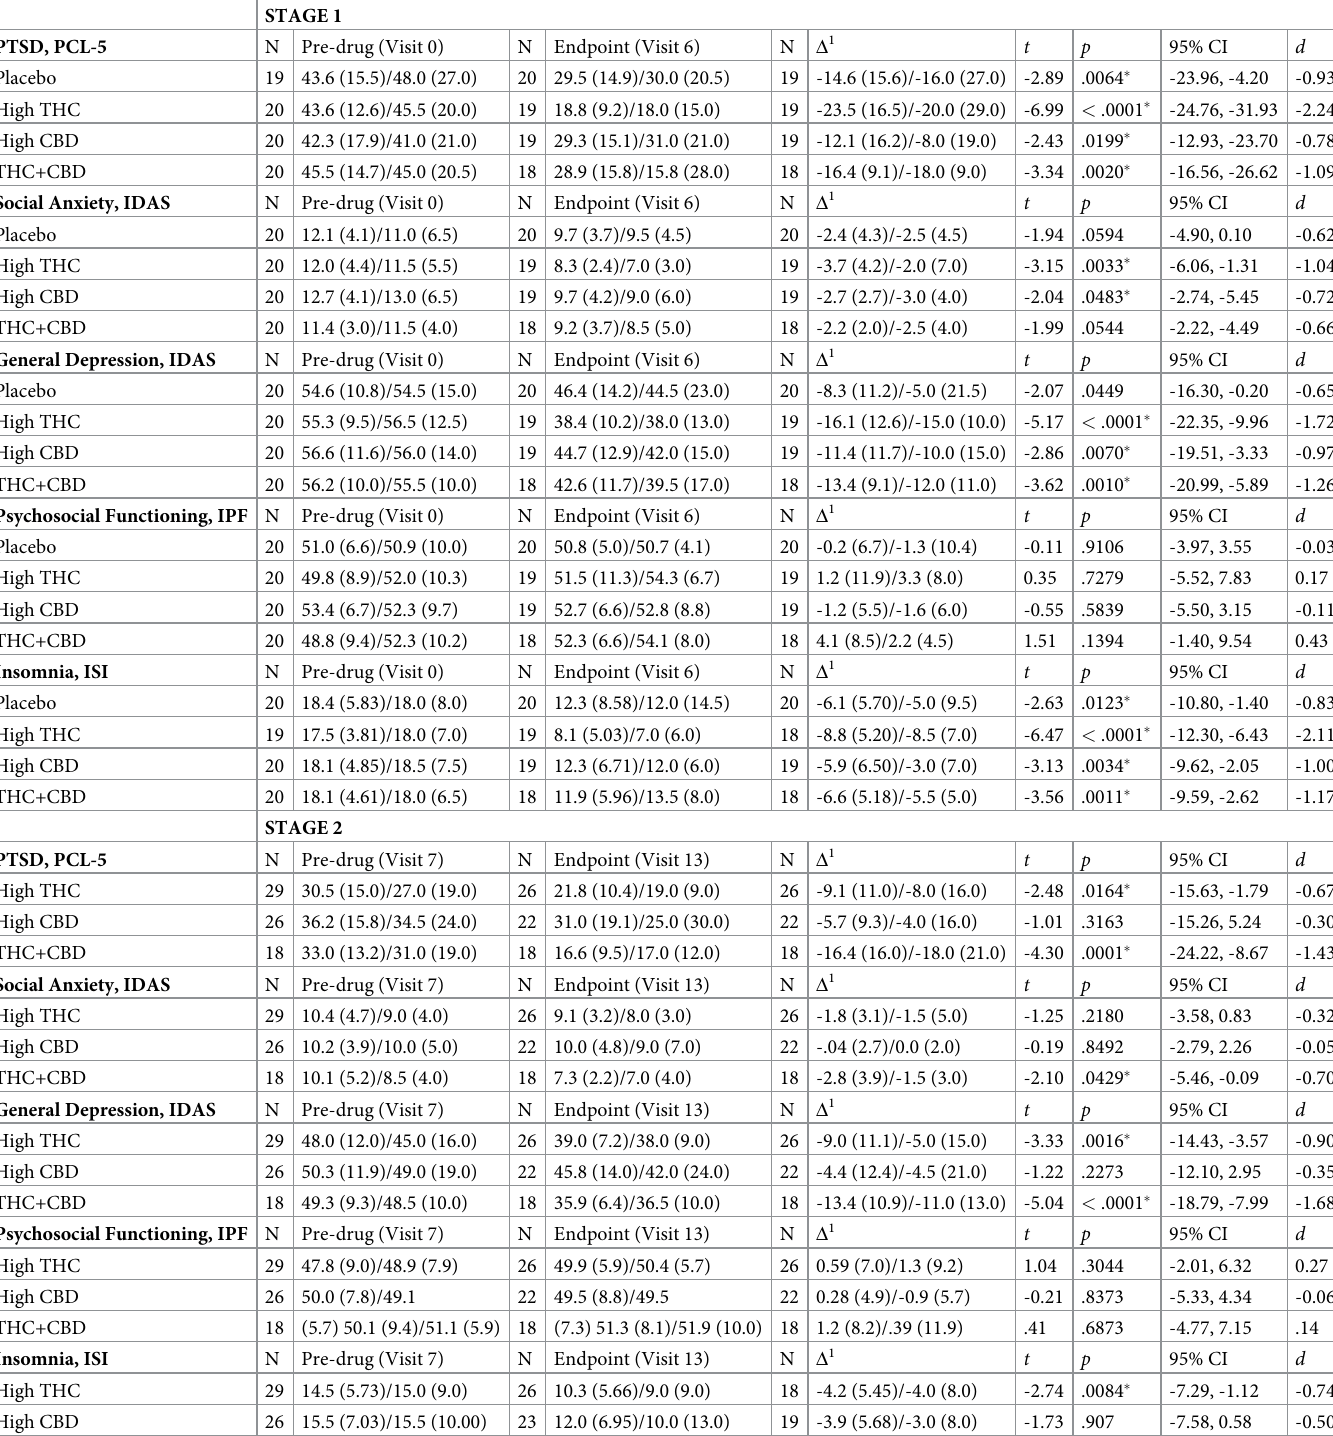
Table 5. Mean (SD)/Median (IQR) and analysis of group change in PCL-5, IDAS social anxiety, IDAS general depression, IPF, and ISI by treatment &